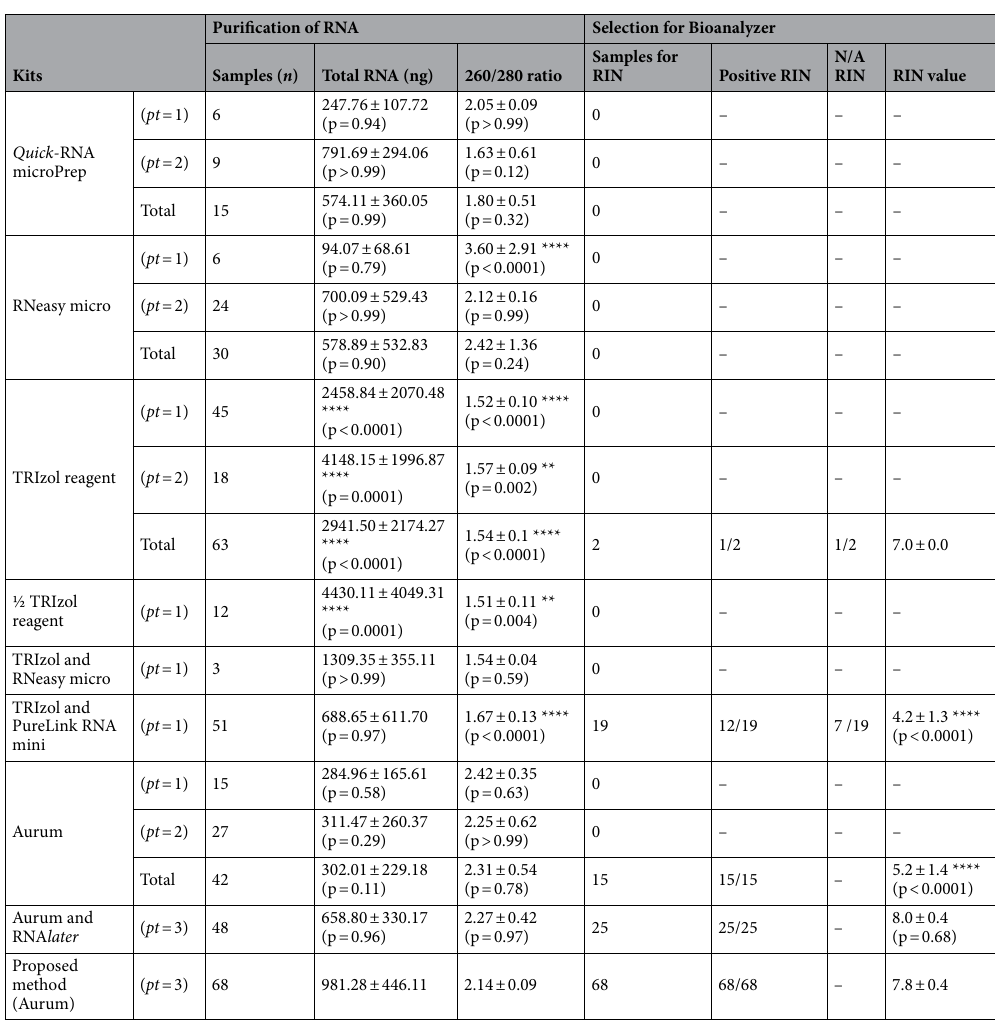
Table 1. Assessment of protocols for RNA extraction from the rat intrinsic laryngeal muscles (ILMs). An analysis of variance (one-way ANOVA followed by Tukey’s post-hoc test) was used to compare the commercial protocols to the experimental method ( P < 0.0001). The pt indicates the number of pooled tissues per extract, while n represents the number of replicates The RNA concentration (ng/μl) (shown as ng total RNA) and 260/280 ratio were measured using a Nanodrop Spectrophotometer. Data are presented as mean ± SD; P < 0.05. RNA degradation was assessed using Agilent 2100 Bioanalyzer. The selection for Bioanalyzer indicates the number of samples applicable for RIN (RNA integrity number) analysis. Individual sample qualifications for QC were selected based on the starting material requirements for RNA-Seq (i.e., greater than 200 ng total